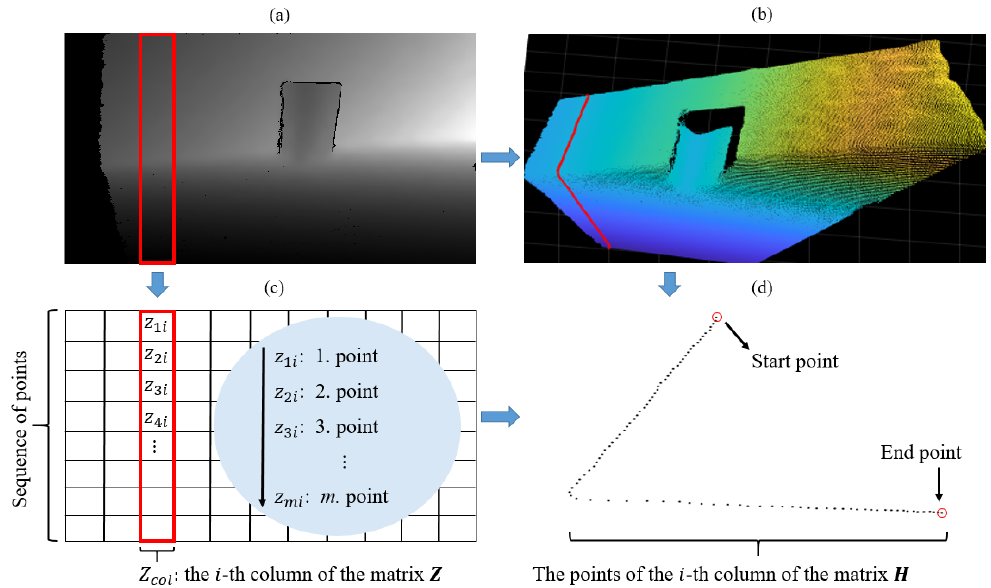
Figure 5. Depth image ( a ) and the corresponding point cloud ( b ). ( c ) shows the matrix form of the depth image, where the points in each column are arranged in order from the first to the last row. Display of 3D points of the highlighted column of the data matrix ( d ), which confirms the hypothesis about the orderliness and sequential occurrence of the data.